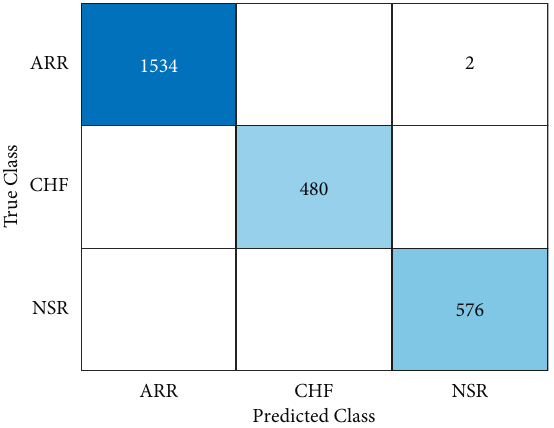
Figure 7: Confusion matrix of classification with